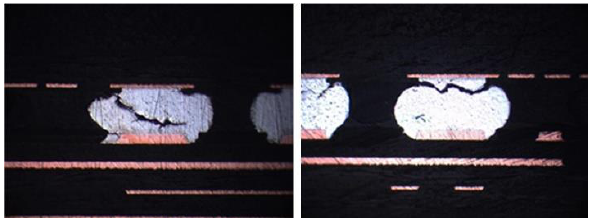
Figure 4. Cracks in the solder joint observed under a metallurgical microscope.